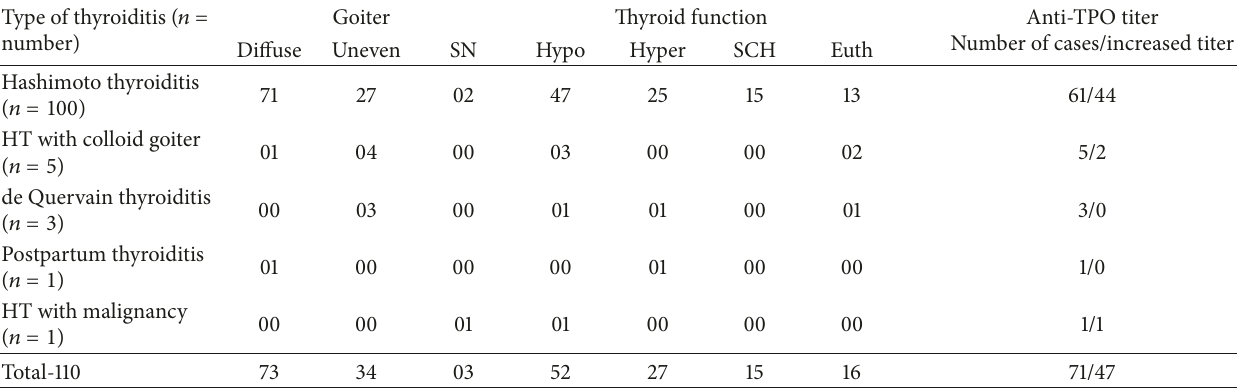
Table 1: Correlation of goiter, thyroid function, and anti-TPO in 110 cases of